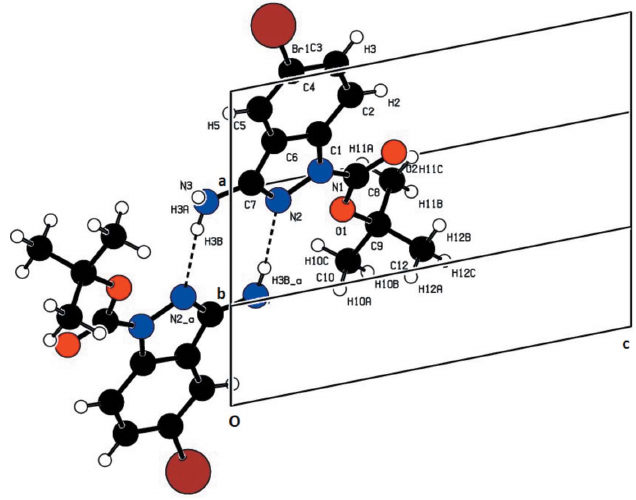
Figure 2 Partial packing viewed along b -axis direction showing the R 2 motif.